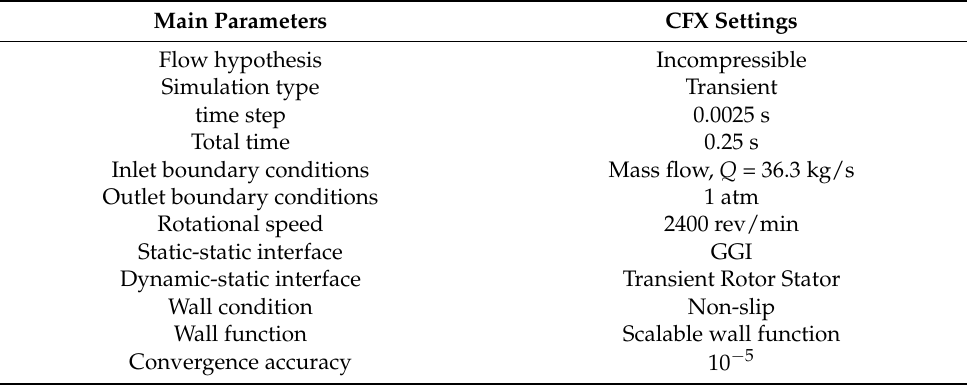
Table 3. Calculation parameter settings of unsteady numerical